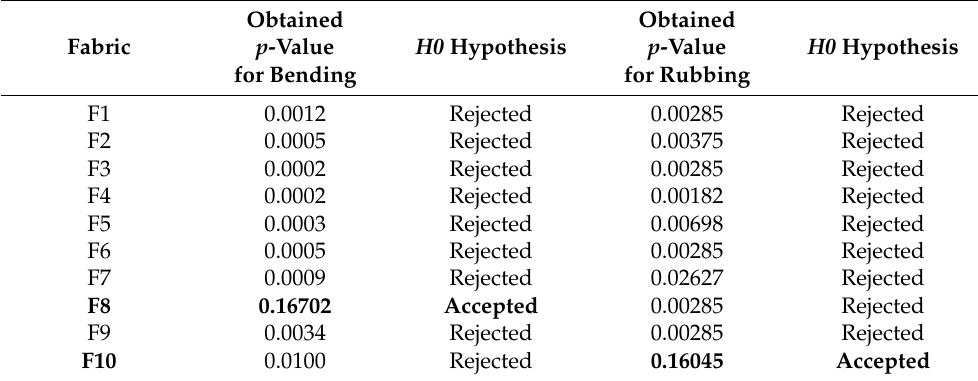
Table 3. Results of Anova Friedman non-parametric tests for the characteristic